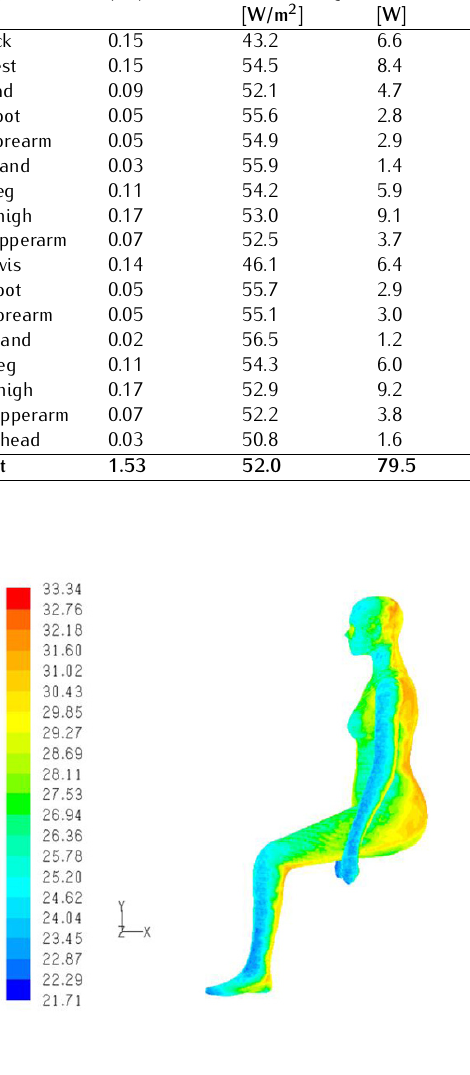
Figure 8. Dry heat flux density from the body surface [W/m 2 ].